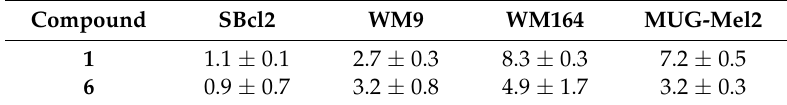
Figure 1. Results of the XTTassay. Melanoma cells (SBcl2, WM9, WM164, and MUG-Mel2) and juvenile skin fibroblasts were treated with 5.0 µ M of 2 to 20 for 72 h (mean ± SEM, n = 4). Compound 1 serves as reference compound. Results of all tested concentrations can be found in the Supplementary Material. Table 2. IC 50 values ( µ M) after 72 h treatment with 1 or 6 (mean ± SEM, n = 4). IC 50 values were determined using the four-parameter logistic curve and individual values of all independent